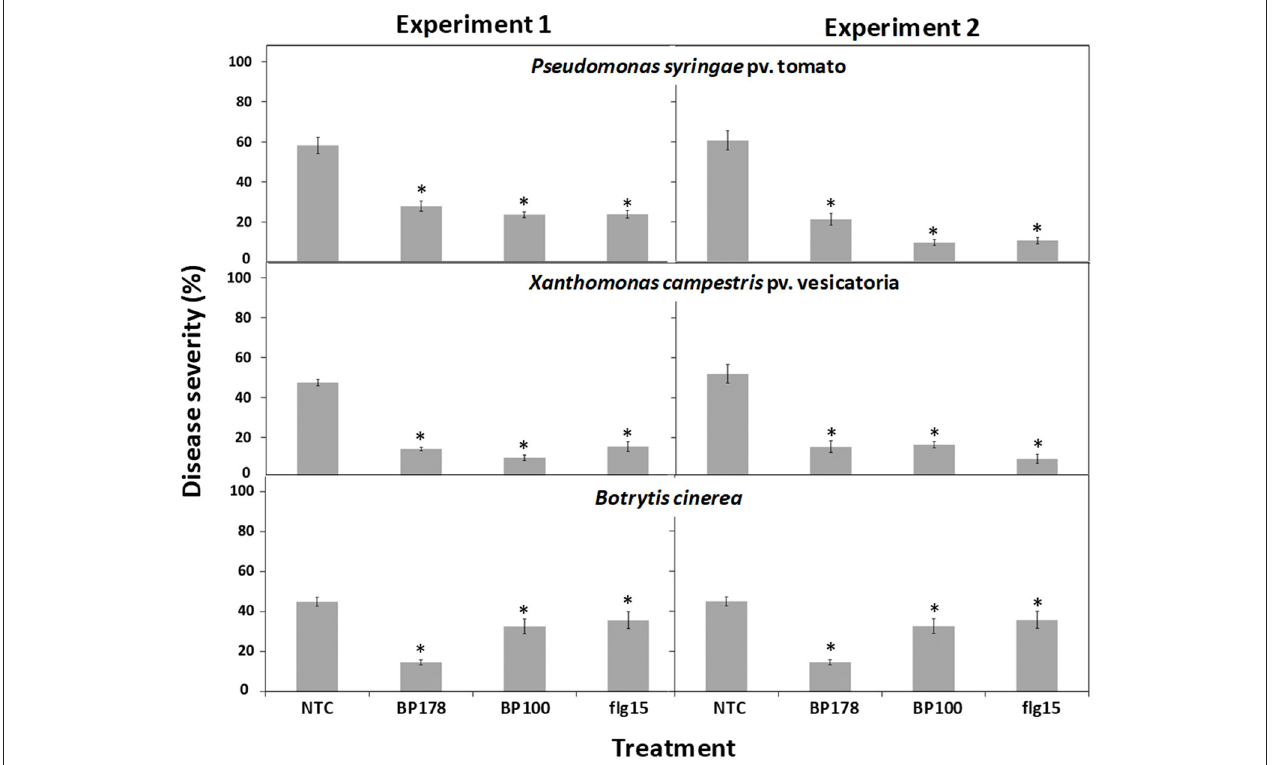
FIGURE 2 | Protection of tomato plants against bacterial and fungal infection after topical treatment with BP178 in comparison with the parent peptide BP100 and flg15. Two independent assays were performed, and peptides were applied at 125 µ M by spraying plants 24h before pathogen inoculation. Disease severity was evaluated on tomato plants 10 days after pathogen inoculation (10 7 ufc/ml for bacterial pathogens; 2.5 × 10 5 conidia/ml for B. cinerea ). Values correspond to the mean disease severity of three replicates of three plants per each treatment. Standard errors are indicated on bars. The asterisk denotes statistically significant differences with non-treated control plants (NTC) (Tukey’s test, p > 0.05).